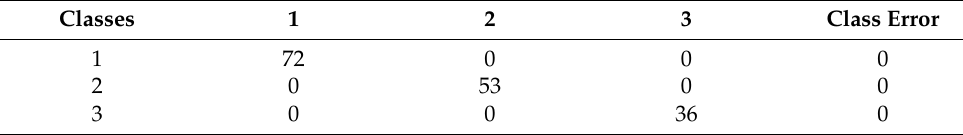
Table 3. Confusion matrix for the random forest algorithm for the LEWS.